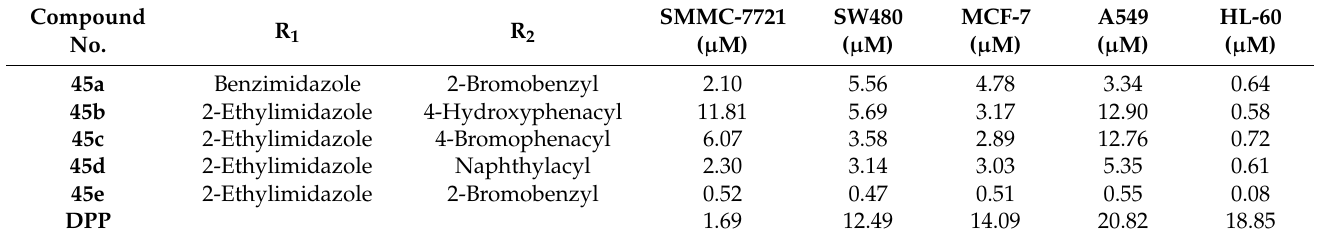
Al-blewi et al. (2013) synthesized numerous derivatives of novel imidazole-1,2,3- triazole hybrids. The synthesized compounds were screened for their anticancer activity against three different types of cancer, namely human colon carcinoma (Caco2 and HCT116), human cervical carcinoma (HeLa) and human breast adenocarcinoma (MCF-7) cancer cells-, using doxorubicin as a standard drug. They found that these derivatives showed potent more cytotoxic activity than standard doxorubicin. The structure of imidazole based triazole hybrid derivatives is given in Figure 52 and in vitro cytotoxic activities of hybrid compounds 46 ( a – e ) are listed in Table 39 [111].